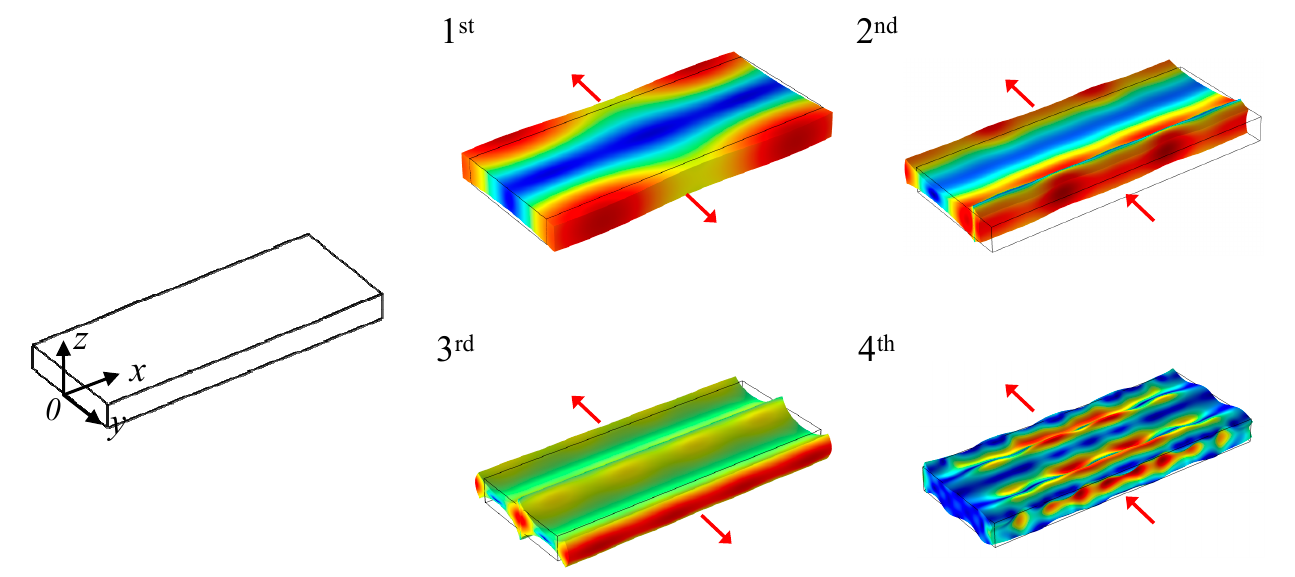
Figure 1. The mode shapes of the 1st to 4th WEMs. The red arrows indicate the vibration direction. Figure 2 gives the displacement distribution along the x -axis for the 1st WEM resonator with a width of 13.5 µ m and lengths of 32–40 µ m in COMSOL Multiphysics, where the origin of the coordinate is located at the plate corner.